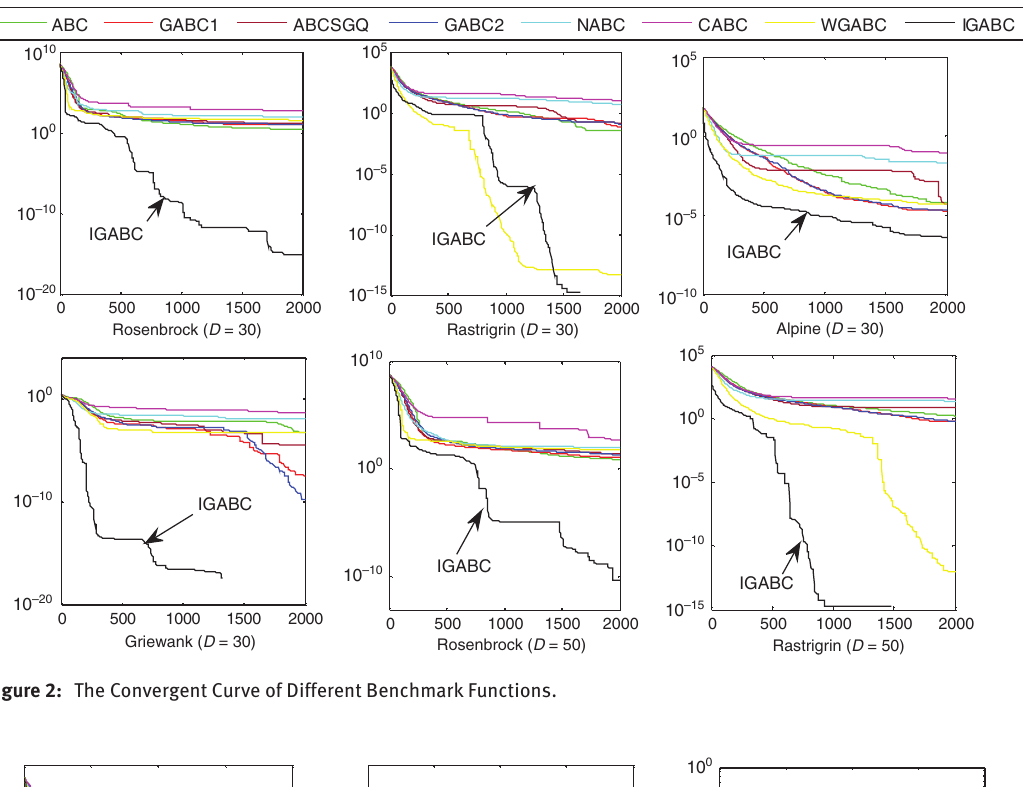
Bold values denotes the optimal values in the experimental